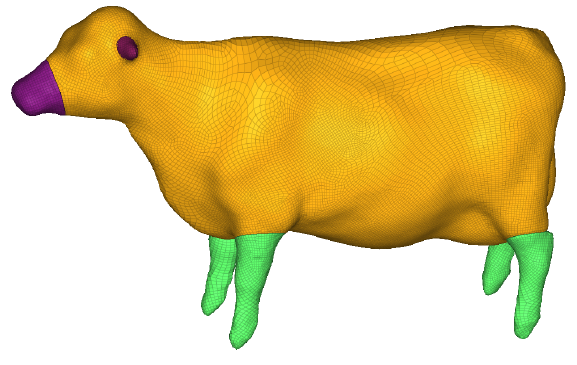
Figure 10. Front view of the overall cow model.